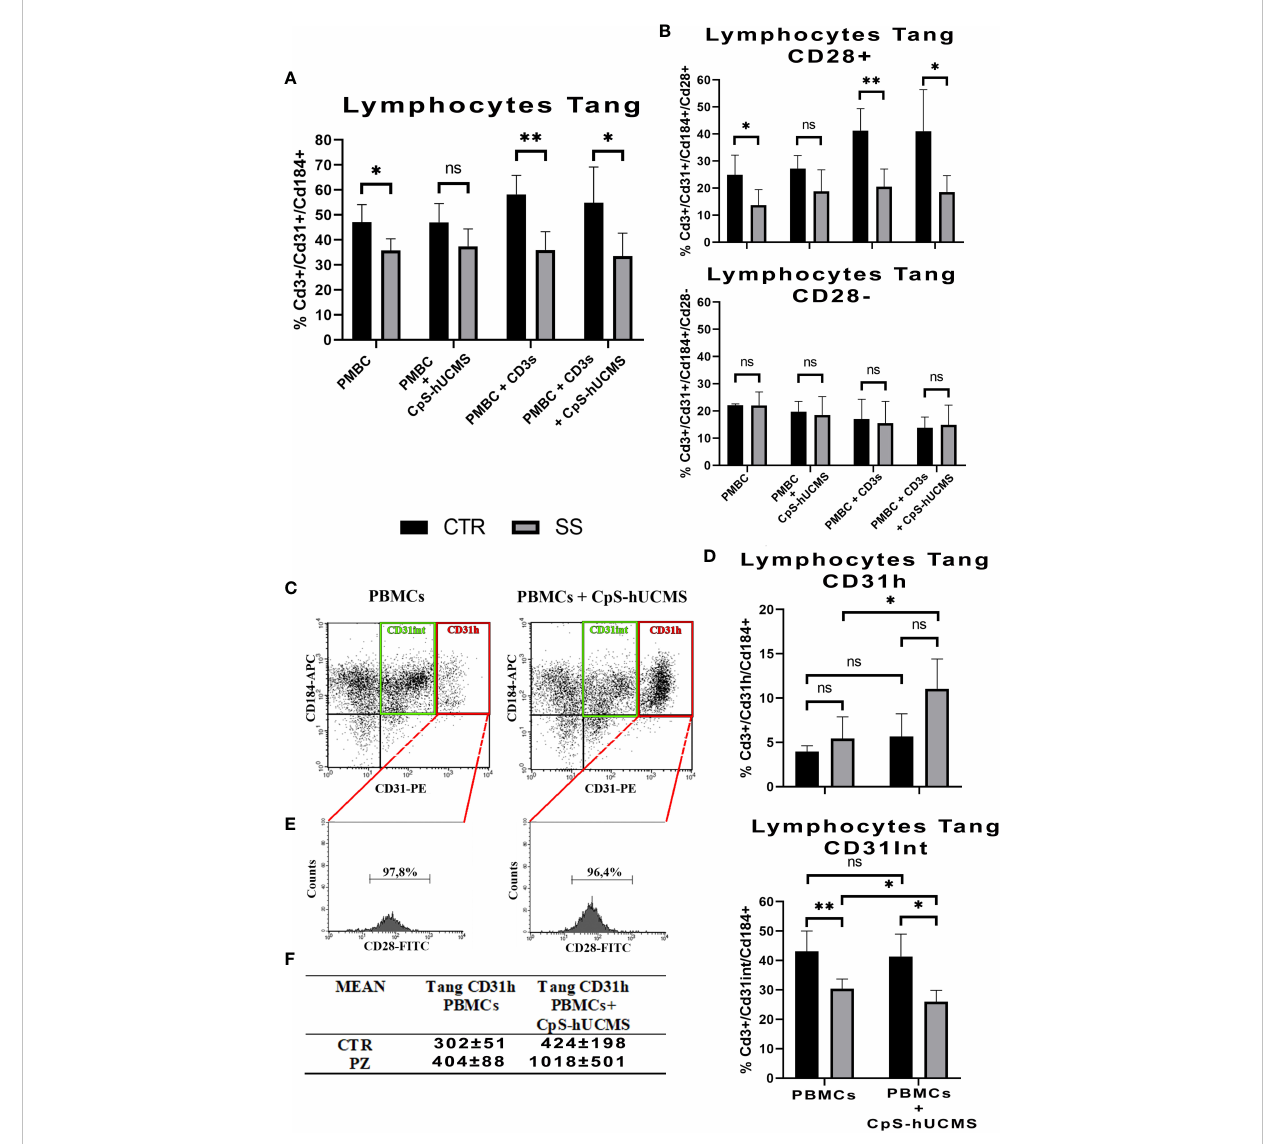
FIGURE 3 (A) Comparison of the percentages of CD3 + CD31 + CD184 + Tang lymphocytes in the PBMCs between healthy subjects (CTR) and SS patients (SS) under different conditions (mean ± S.D., Mann-Whitney T-Test, * p<0.05, ** p<0.005). No statistically signi fi cant differences were found in Tang lymphocyte percentages between conditions within the control and patient groups. (B) Percentage of CD28 + and CD28 - Tang lymphocyte subsets within the total Tang lymphocyte population of healthy subjects and SS patients at the different conditions. (mean ± S.D., Mann-Whitney T-Test, p<0.05*, p<0.005*, n.s. not signi fi cant). No statistically signi fi cant differences were found in the percentages of CD28 + and CD28 - Tang lymphocytes between conditions in the control group and in the patient group, with the exception of the comparison between control PBMCs treated with soluble anti-CD3 and PBMCs regarding CD28 + (p<0.05). (C) Representative cyto fl uorimetric dot-plots of total Tang lymphocytes belonging to a SS patient after fi ve days of incubation in the absence (left) and presence (right) of CpS-hUCMS. The population in the red rectangle was called CD31 H Tang; while that in the green rectangle is the Intermediate Tang. (D) Comparison of the percentages of Tang CD31 H and Tang CD31 Int lymphocytes in the total Tang CD3 + CD31 + CD184 + of healthy subjects (CTR) and SS patients (SS) in PBMCs and in PBMCs maintained in the presence of CpS- hUCMS. Signi fi cant was the increase in CD31 H in PBMCs from SS in the presence of CpS-hUCMS. (mean ± S.D., Mann-Whitney T-Test & Wilcoxon T-Test, p<0.05*, p<0.005*, n.s. not signi fi cant). (E) Representative percentage of CD28 in the CD31 H in selected SS patient. Almost all CD31 H also expressed CD28. (F) Table with averages of CD31 H in controls and patients with and without